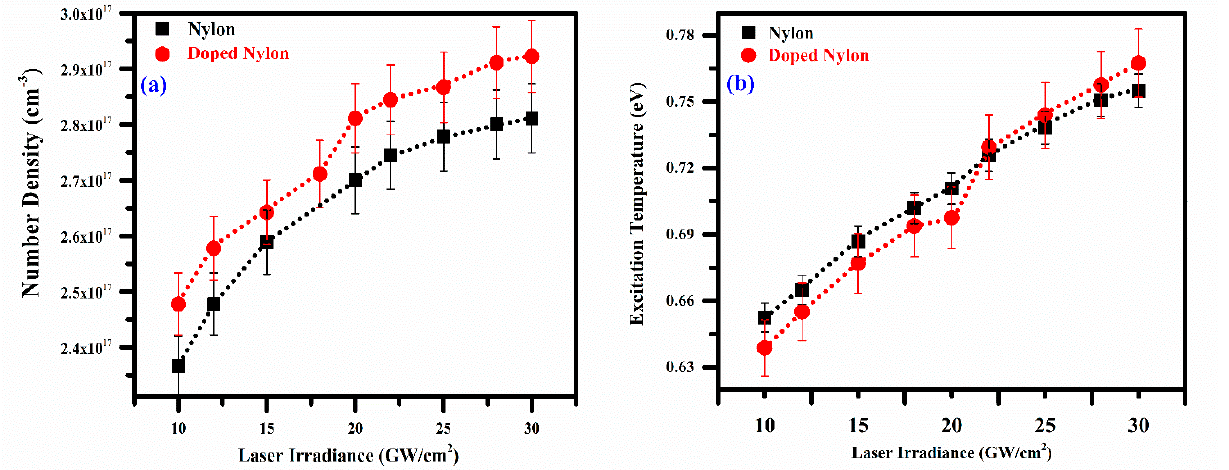
Figure 7. ( a ) Variation in the electron number density and ( b ) Variation in excitation temperature of the pure and doped nylon plasma as a function of laser irradiance.